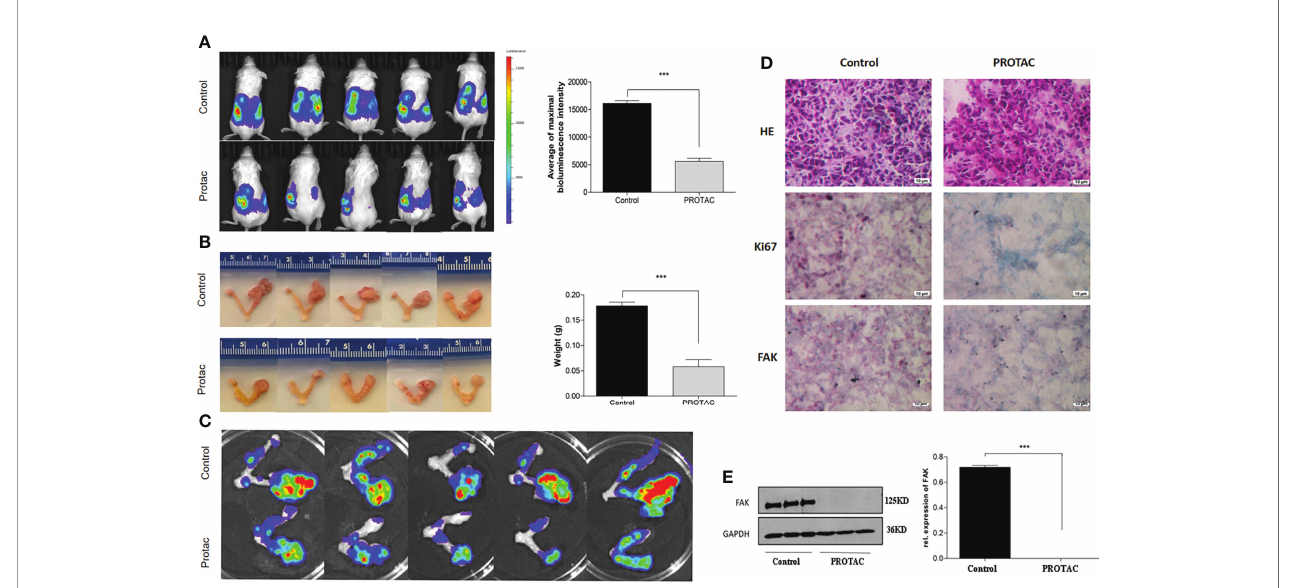
FIGURE 6 | FAK PROTAC inhibits OC growth and metastasis. (A, B) Ovarian tumor growth and metastasis were shown by bioluminescence following three-week treatment with vehicle and FAK PROTAC in live animals (A) and ovarian tumors were also imaged (B) and weighted (C) in vehicle and FAK PRTOAC treated mice. (D) H.E and immunohistochemical staining against FAK and Ki67 of ovarian tumor sections in FAK PROTAC and vehicle treated mice. (E) WB analysis of FAK protein in ovarian tumors of FAK PROTAC and vehicle treated mice. (*** p